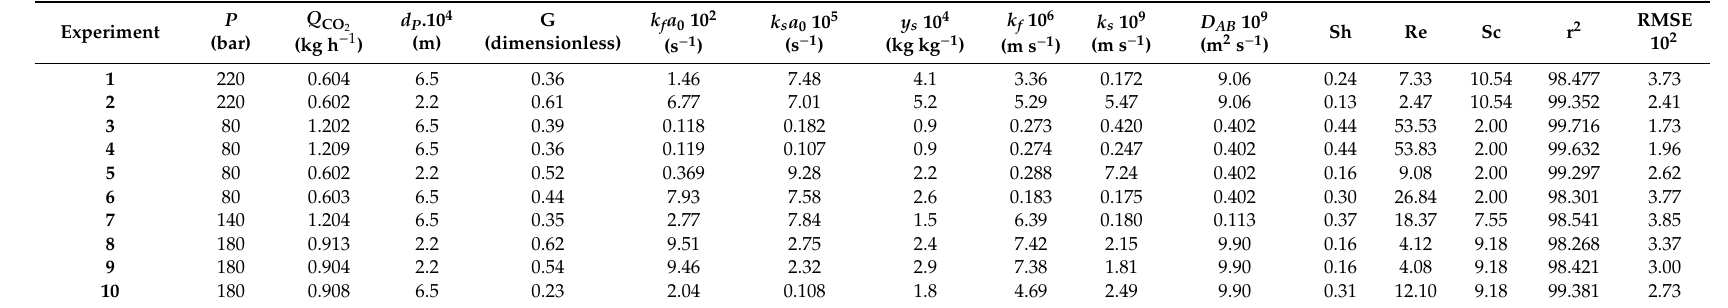
Table A3. Operating conditions estimated TWO parameters from best fitting and modeling errors used by